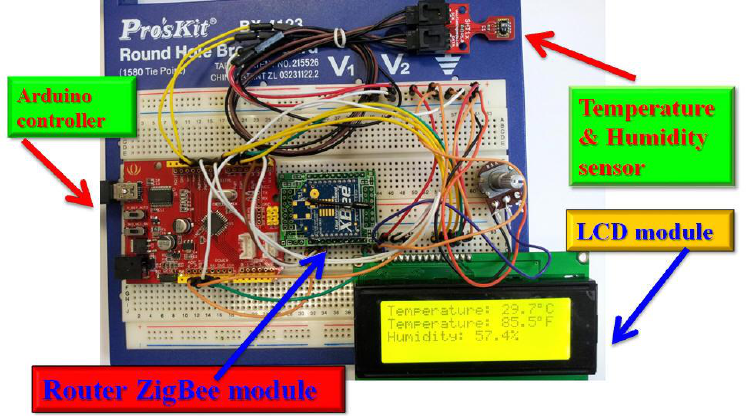
Figure 38. Introduction to the transmitter side of our ZigBee network.